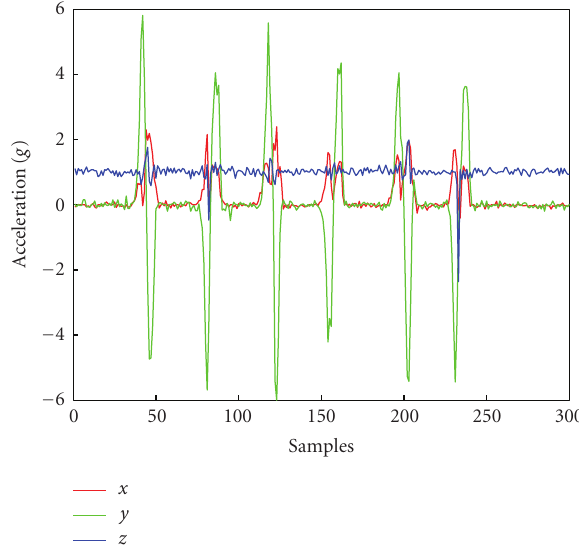
Figure 4: Nokia 5500 accelerometer data (lateral movement of phone across the